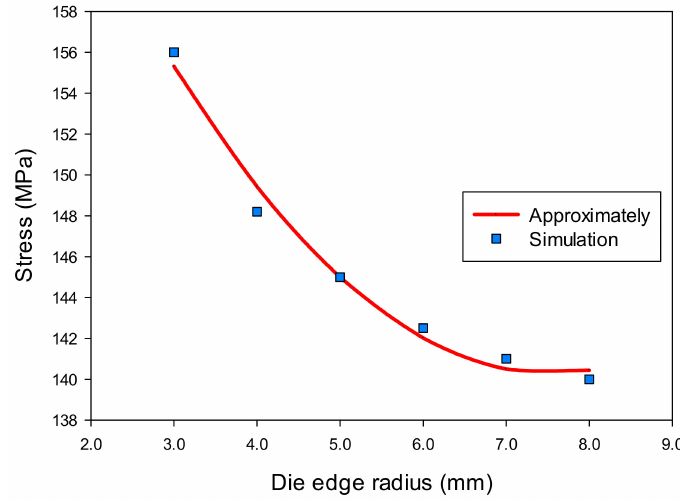
Figure 12. The effect of die edge radius on stress.